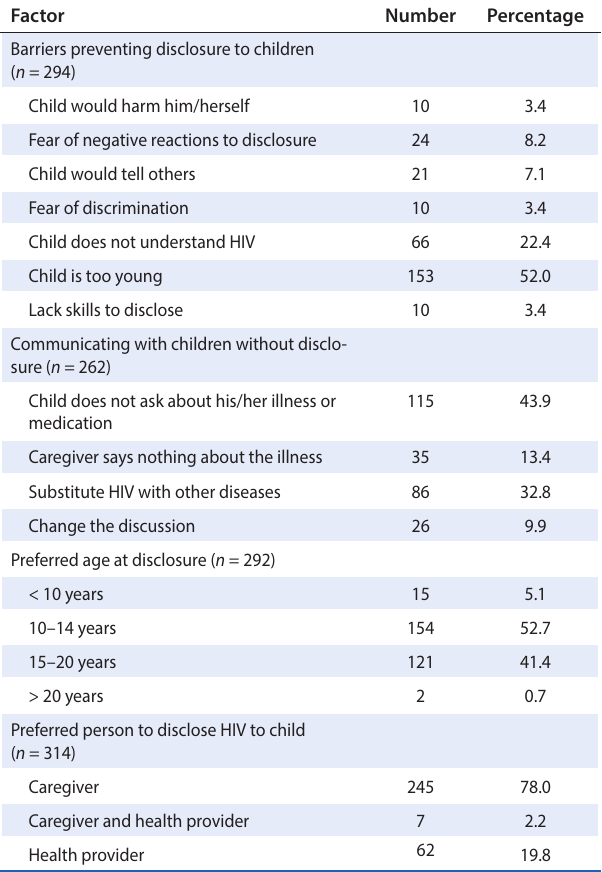
Table 4: Caregiver-reported barriers to disclosure and intentions to disclose